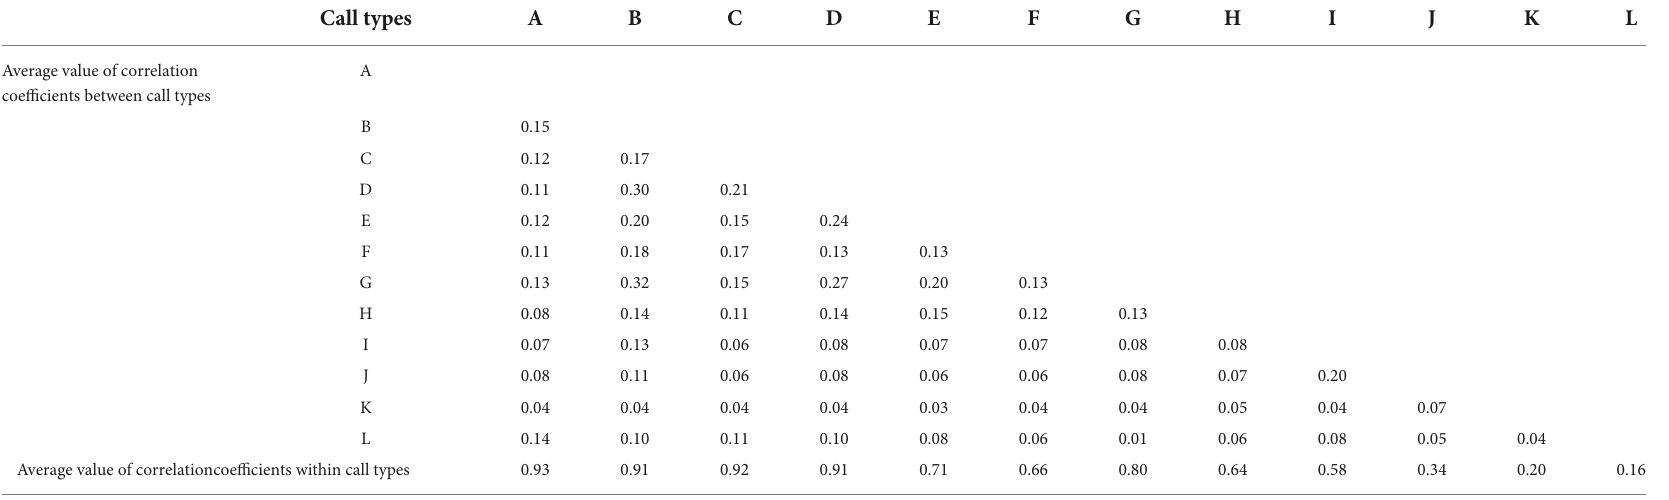
TABLE 2 Average value of correlation coefficients for signals within each call type and between call